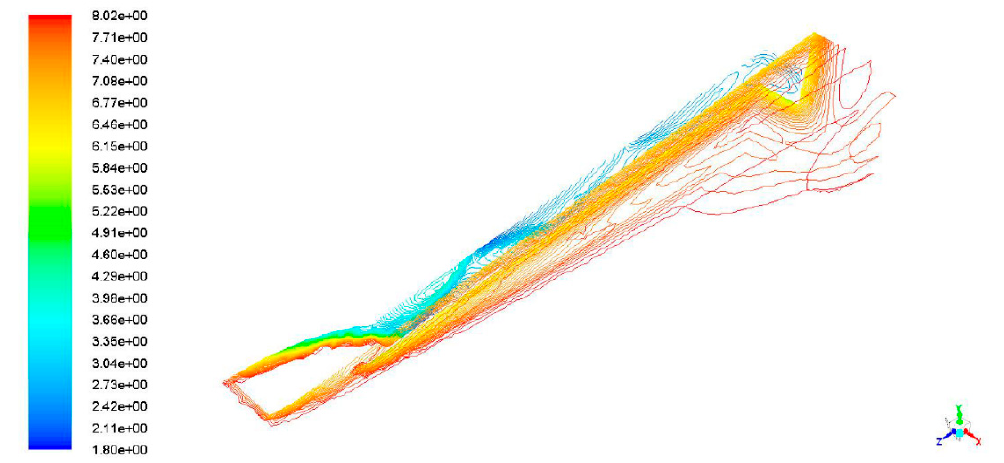
Figure 34. Oblique shock observed at the outward chamfered scramjet wall at Mach 8.